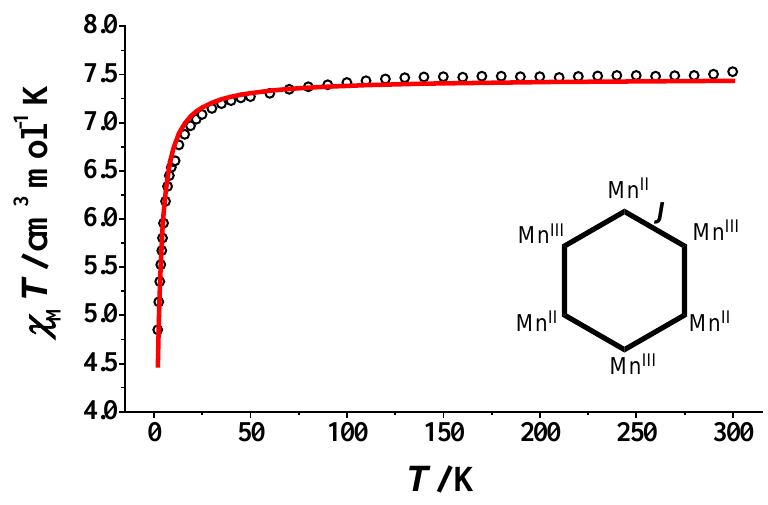
Figure 6. χ M T versus T plot for complex 2 . The solid red line is the fit of the data; see the text for the spin Hamiltonian and the corresponding fit parameters. (inset) J -coupling scheme employed for the determination of the fit parameters.